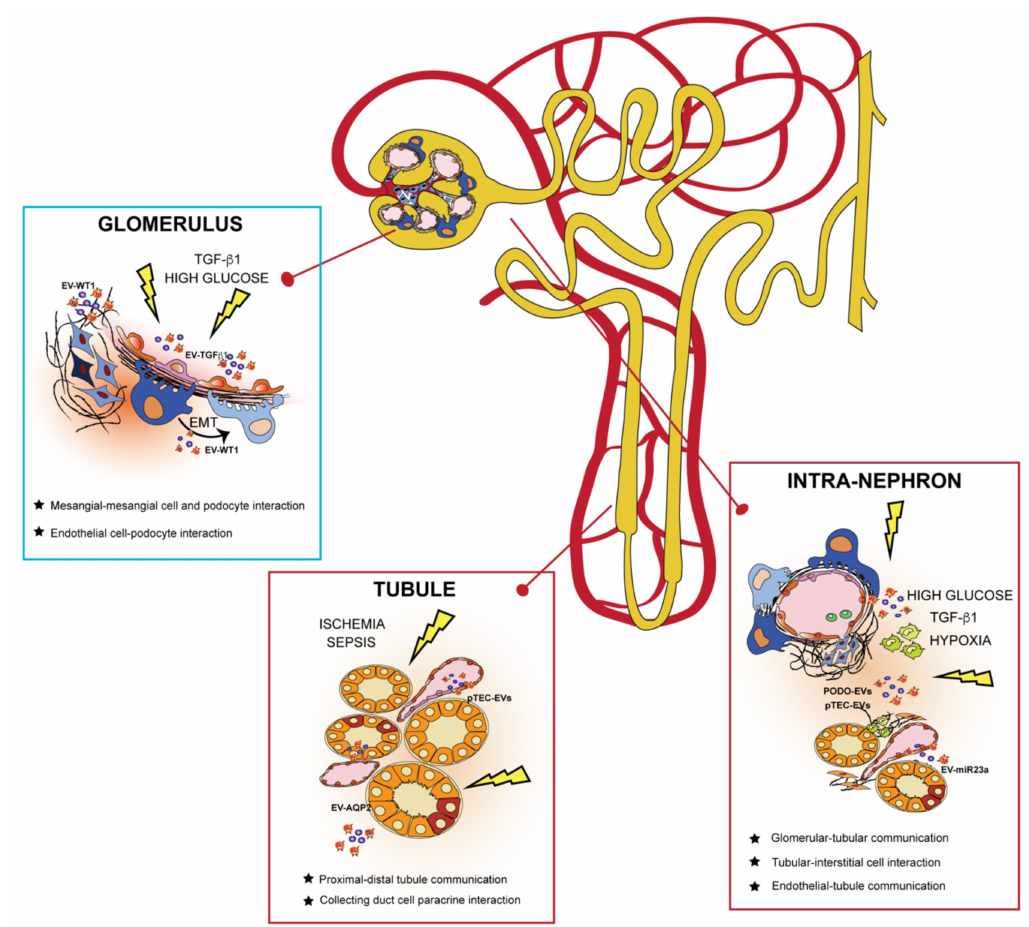
Figure 2. Extracellular vesicles (EVs) govern intracellular communication between intra-nephron compartments. EVs released from different glomerular cells and tubule segments can interact in the same physical compartment or mediate communication from distant nephron sections in physiological and pathological conditions. In the glomerulus, EVs released from mesangial and endothelial cells (such as EV-TGF β ) mediate a paracrine response to injury by affecting neighboring kidney cells. EVs of podocyte origin (EV-WT1) are released in the urine during pathological conditions, behaving as biomarkers of glomerular kidney damage. In the tubule, EVs are secreted by tubular epithelial cells (TECs) to maintain fluid homeostasis and electrolyte balance (EV-AQP2) in the body. After an injury, EVs from both podocytes (PODO- EVs) and proximal TECs (pTEC-EVs) mediate intra-nephron interaction with interstitial fibroblasts and tissue-infiltrating macrophages, promoting progression to chronic kidney